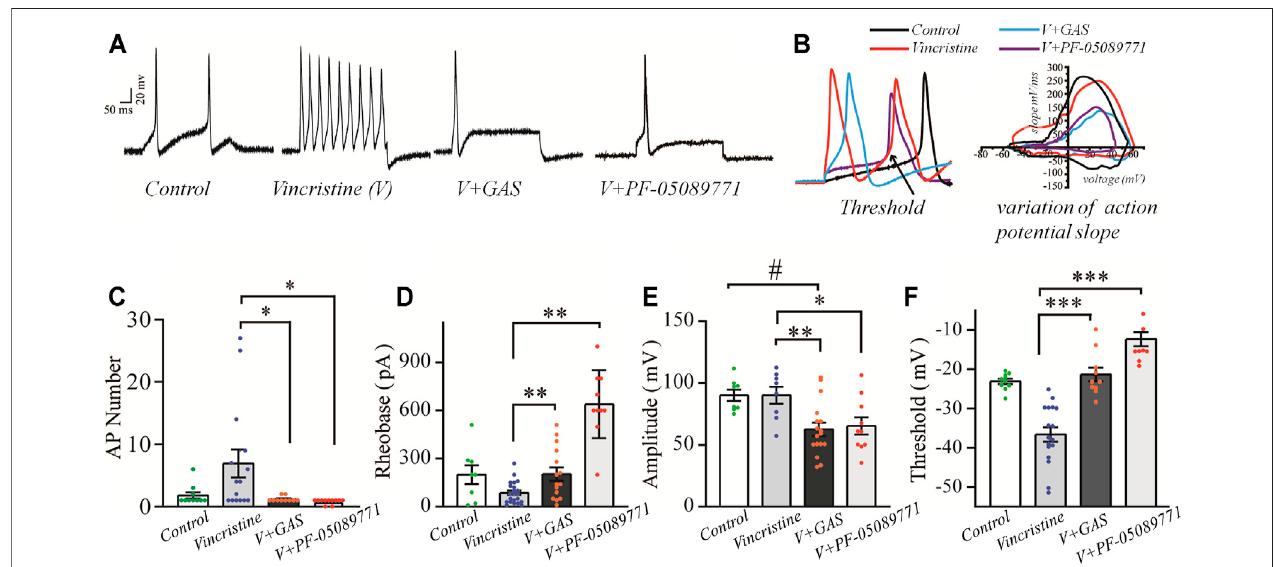
FIGURE 2 | The in fl uences of GAS on the excitability of vincristine-induced hyperexcitability of small-sized DRG neurons: (A) typical action potential curve of spike fi ringofeachexperimentalgroup; (B) phaseplotoftheactionpotential (left), andtheraisingslopeofactionpotential (right);(C) theeffectofGASonthenumberofaction potentials fi redbyDRG neurons ineach group; (D) histogram ofthe effects ofGASon action potential rheobase ofDRGneuronsineach group; (E) thein fl uenceofGAS on the amplitude of the fi rst peak of action potential fi red by DRG neurons; (F) regulation of GAS on the fi ring threshold of action potentials ofDRG neurons in each group ( #p < 0.05, ### p < 0.001, compared to the control group; *p < 0.05, **p < 0.01, ***p < 0.001, compared to the model group; ANVOA- Bonferroni Test).